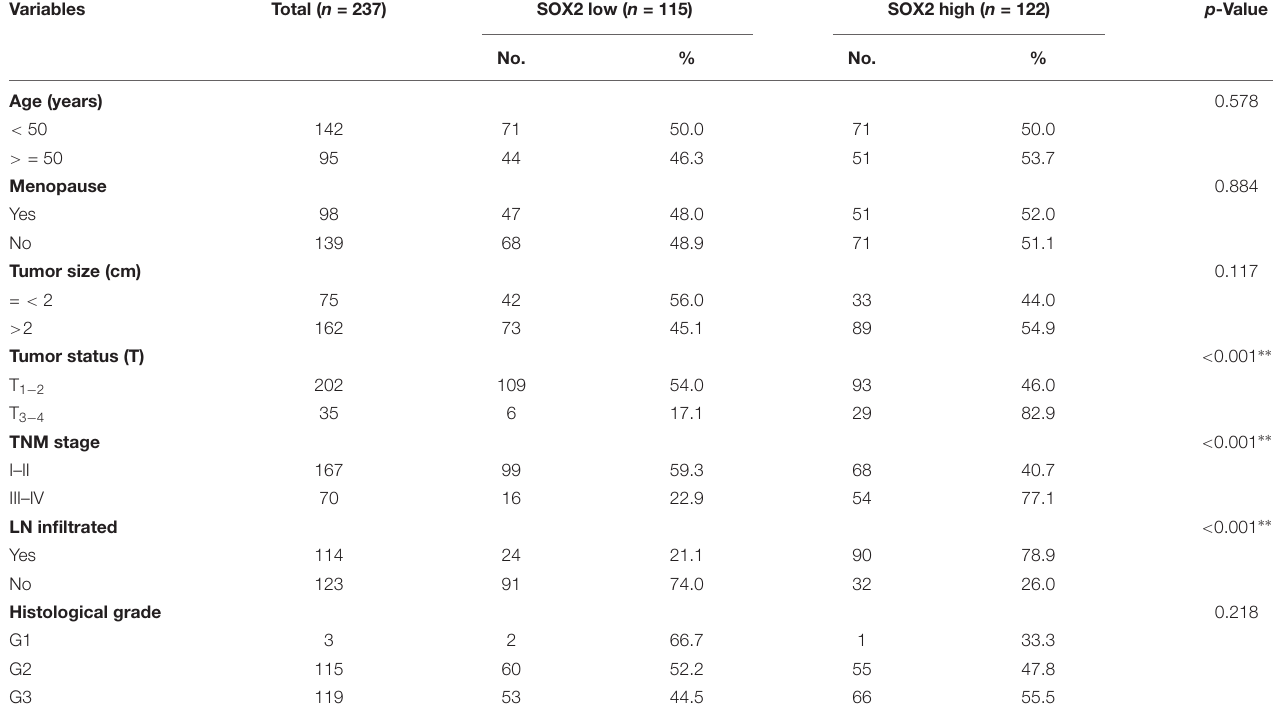
TABLE 1 | Clinicopathological variables and SOX2 expression in 237 TNBC patients.